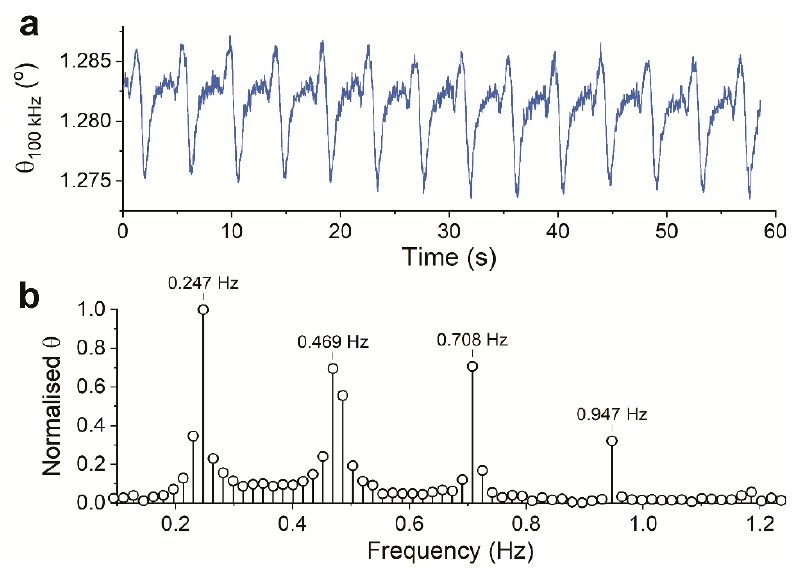
Figure 5. ( a ) The magnitude of the recorded impedance of the contractile hPSC-CMs, recorded by Pt wires in the well-plate setup, plotted over time. ( b ) Frequency components of the recorded magnitude data shown in (a).